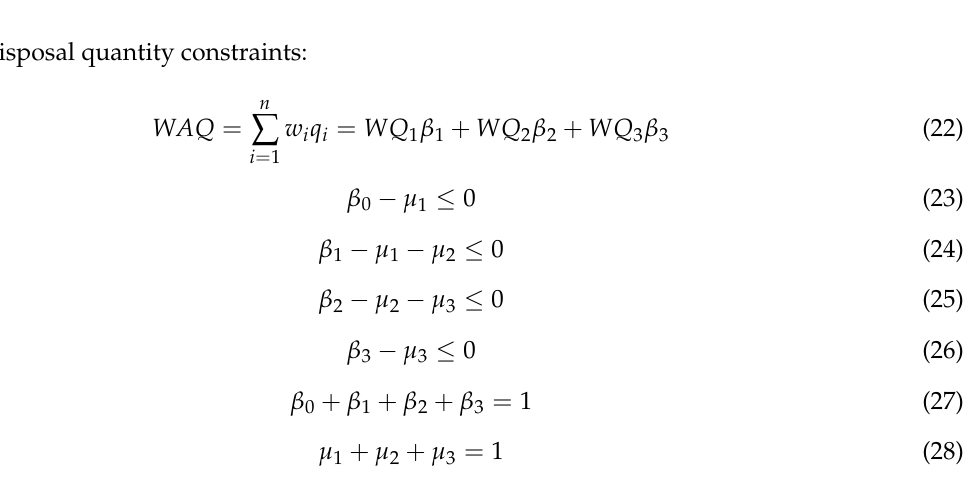
Figure 8. Waste disposal cost.